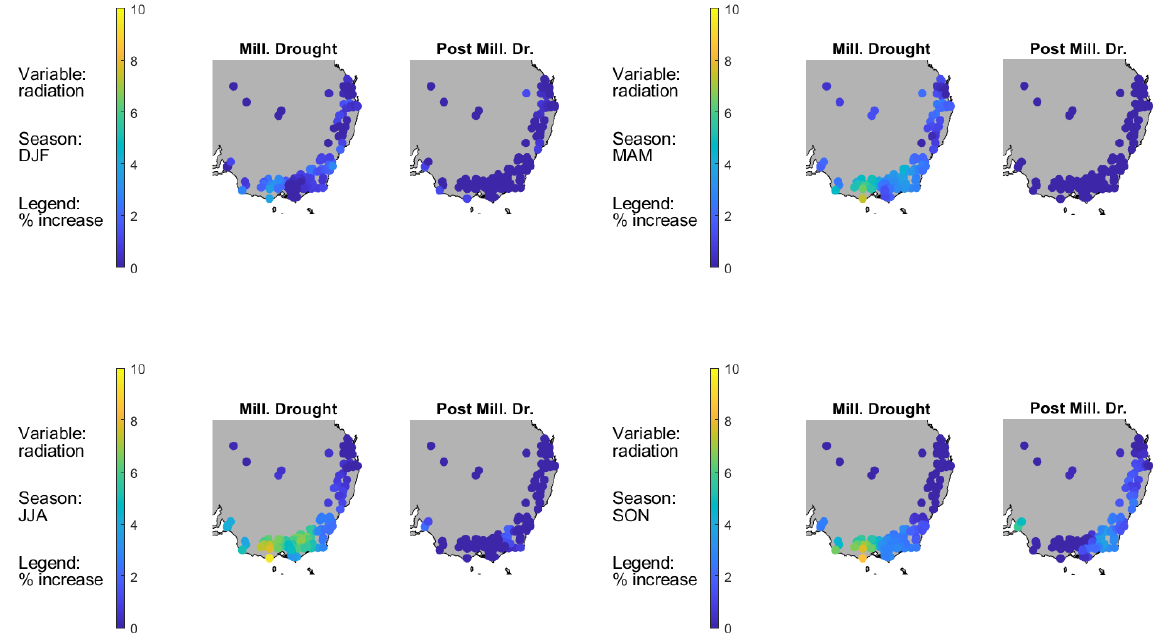
Figure D5. Same as Fig. D1 except for radiation. Based on data from Fowler et al. (2021).